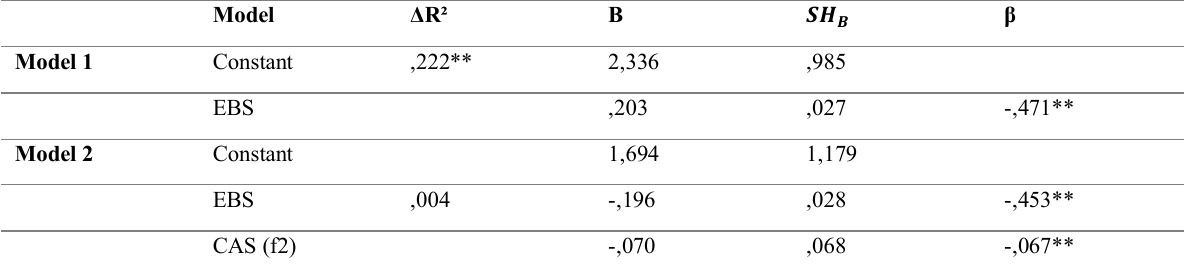
Table 3: Multiple Linear Regression Test Results